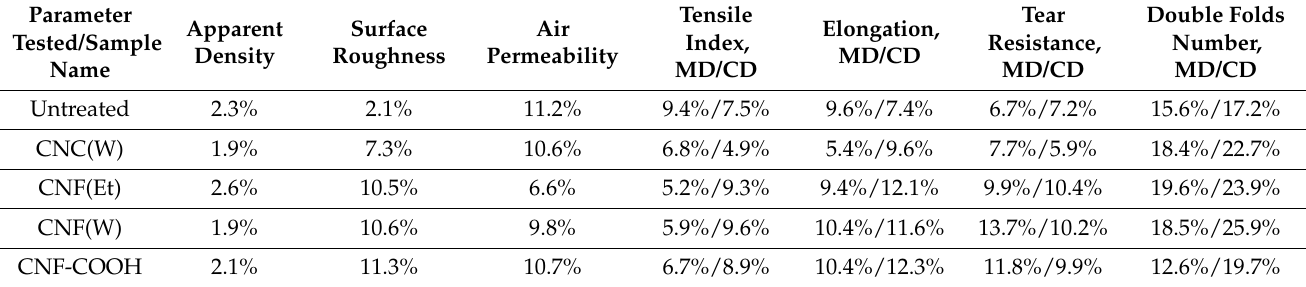
Table 1. The coefficients of variation for all the measurements conducted in the presented re- search.